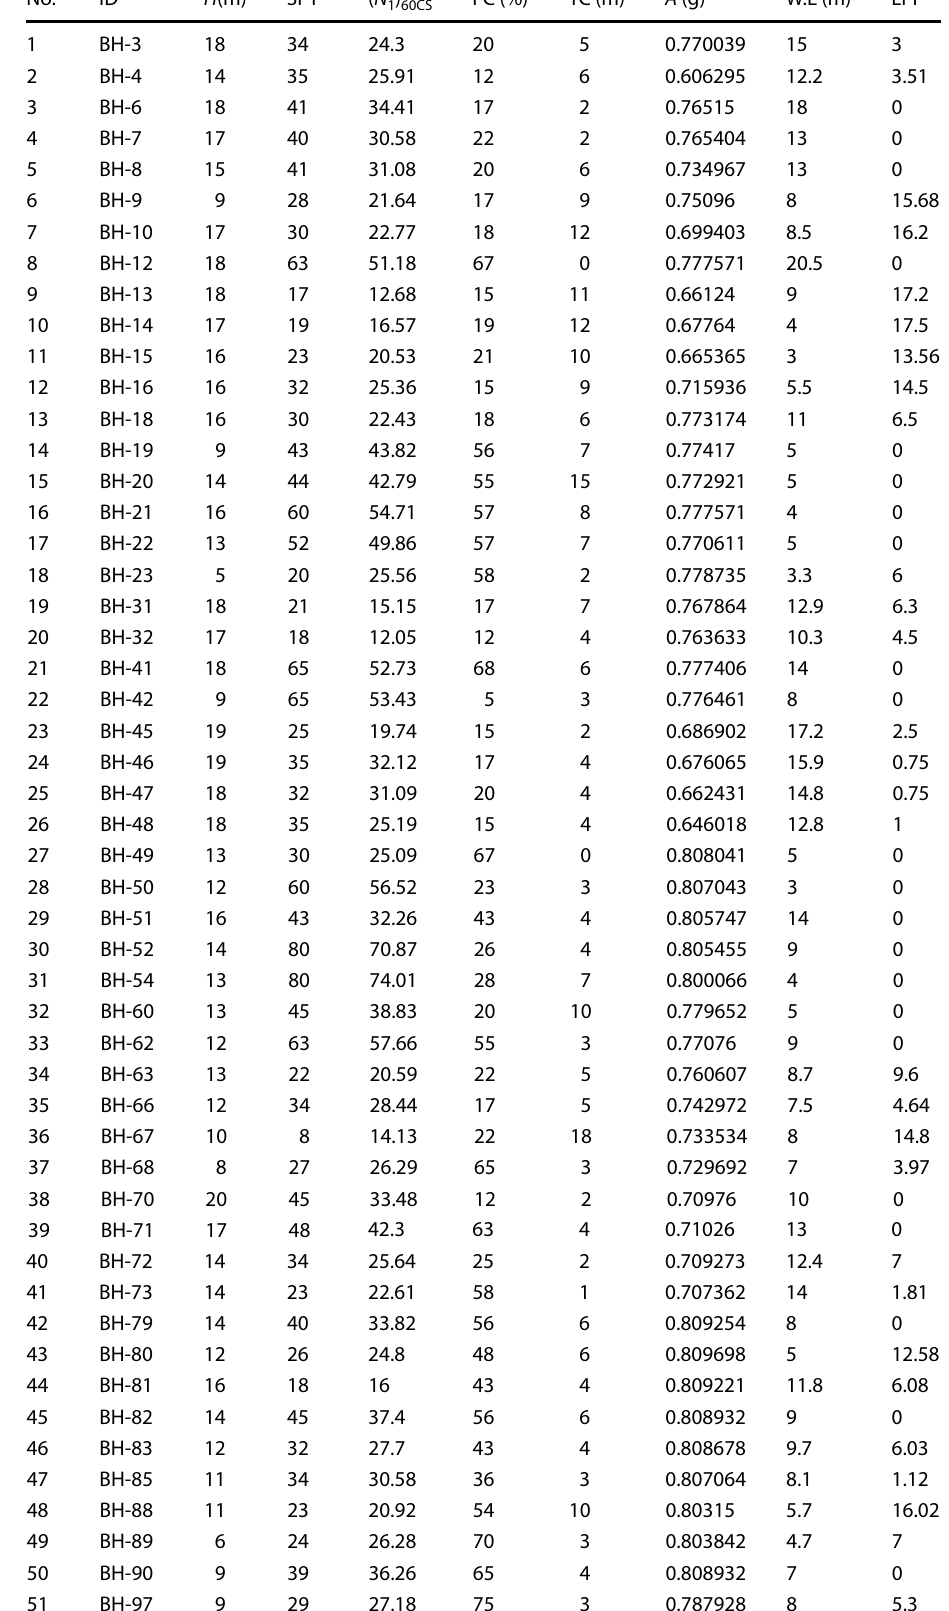
Table 4 Characteristics of the